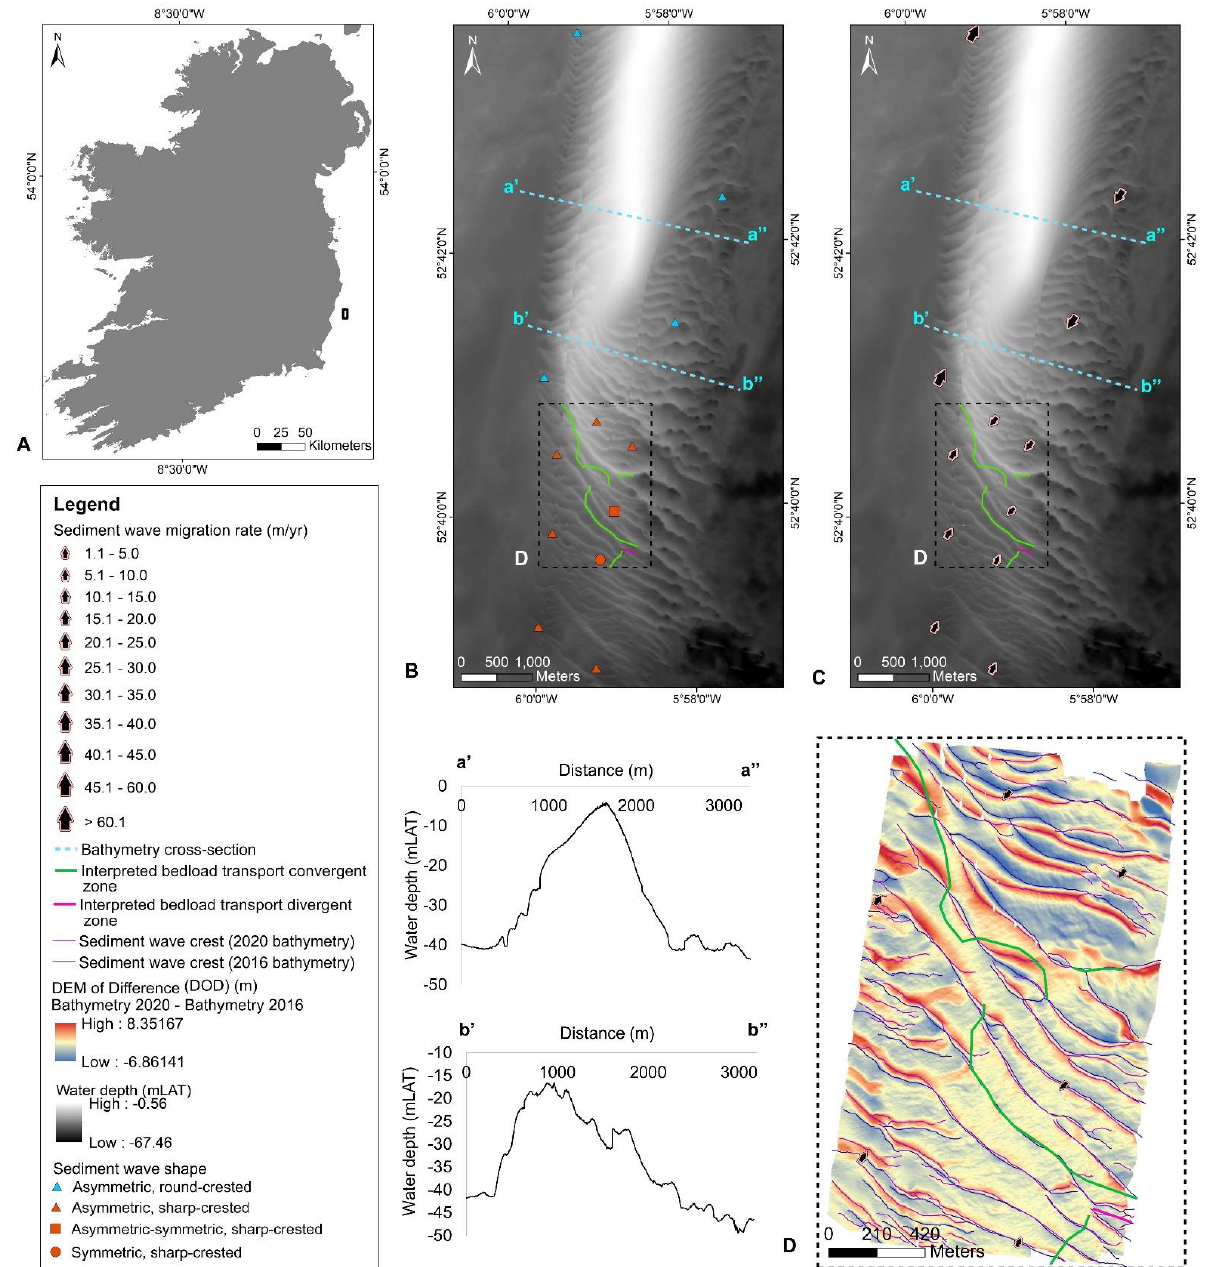
Figure 8. Sediment wave translation rates and shapes at the southern extent of Arklow Bank in the Irish Sea: ( A ) location of Arklow Bank; ( B ) sediment wave shape with locations of cross-sections a and b; ( C , D ) sediment wave translation rates.( B , C ) bathymetry source: composite map produced from INFOMAR datasets (https://www.infomar.ie/data [Accessed: 10 June 2021])